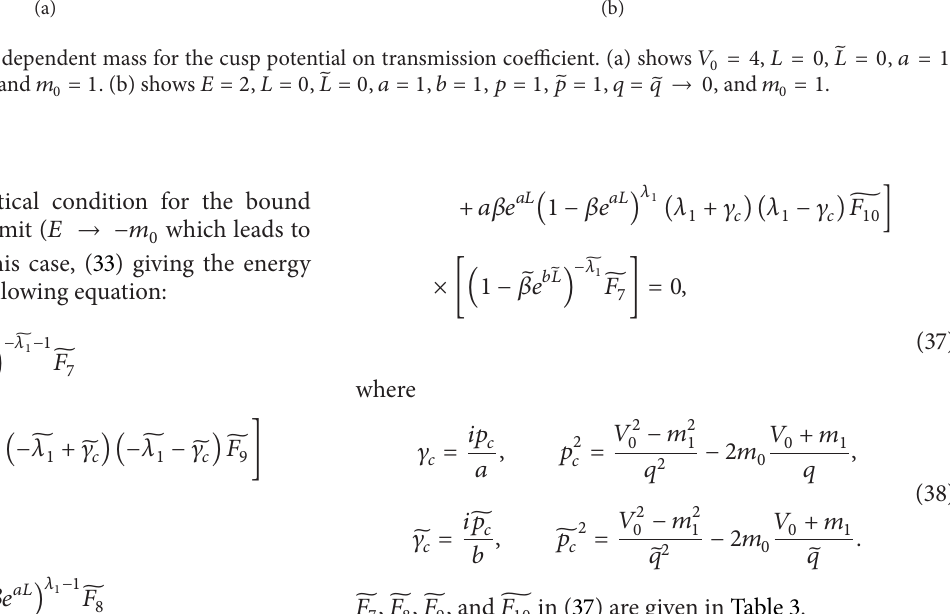
Figure 6: The effect of position dependent mass for the cusp potential on transmission coefficient. (a) shows 𝑉 0 = 4 , 𝐿 = 0 , 𝑏 = 1 , 𝑝 = 1 , ̃𝑝 = 1 , 𝑞 = ̃𝑞 → 0 , and 𝑚